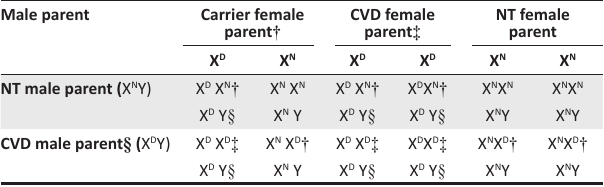
TABLE 1: Inheritance of colour vision deficiencies from parent to